Question: According to the figure, is the described quantity increasing or decreasing?
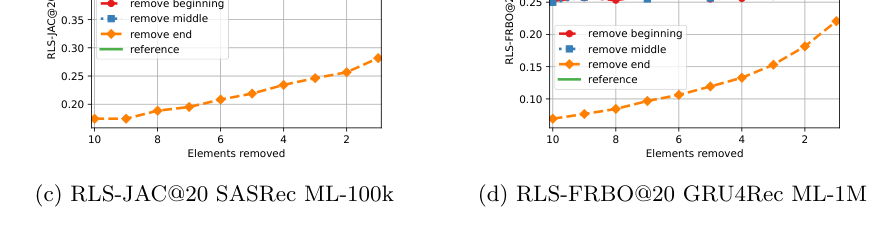
Answer: increasing